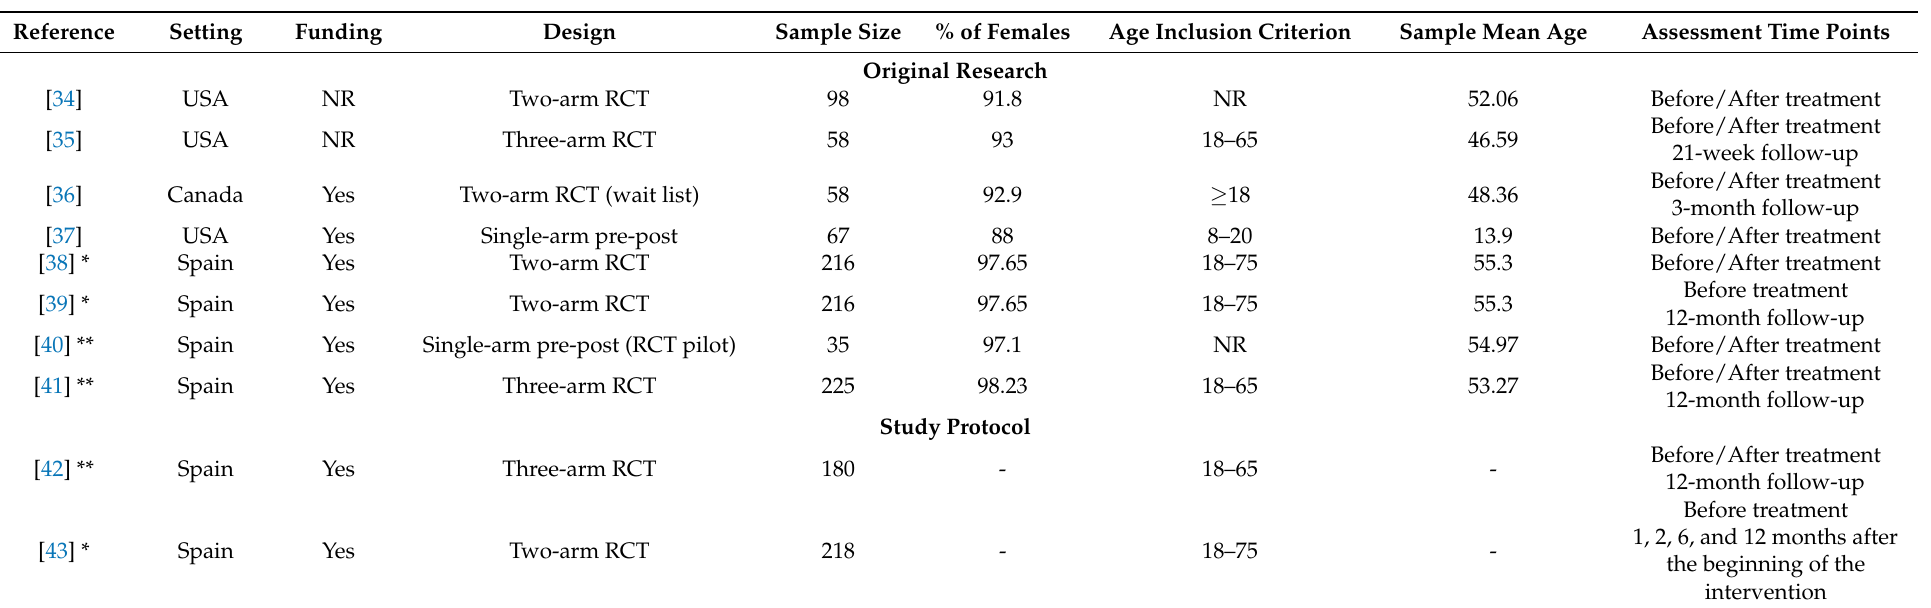
Table 2. Basic features of